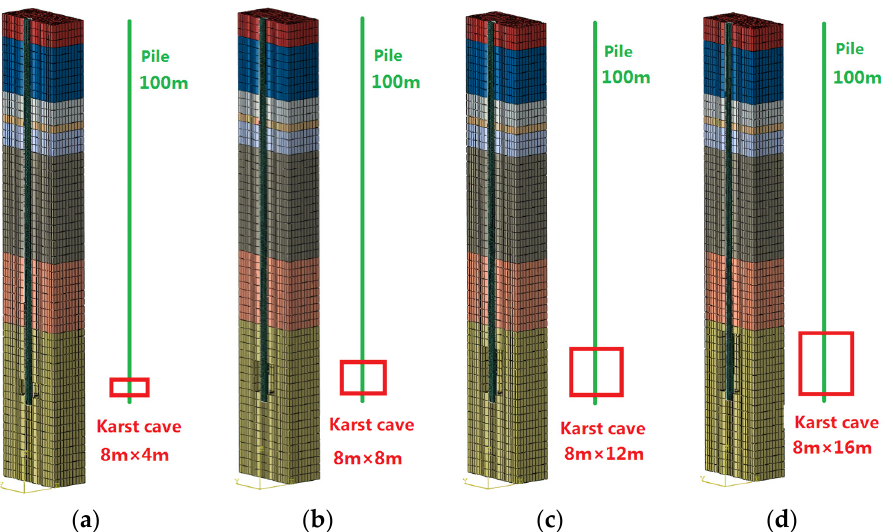
Figure 3. Schematic diagram of the finite element model of the rock-socketed piles with different cave heights. ( a ) Height 4 m, ( b ) height 8 m, ( c ) height 12 m, ( d ) height 16 m.